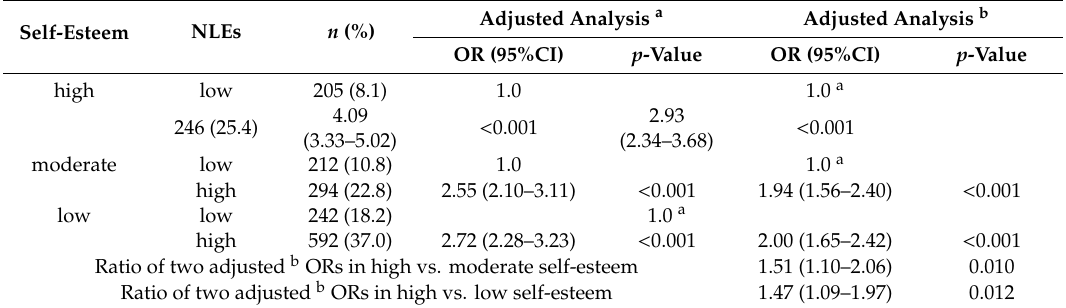
Table 3. Number, % and OR of SI in relation to NLEs by level of self-esteem: 15-school study, China. Self-Esteem